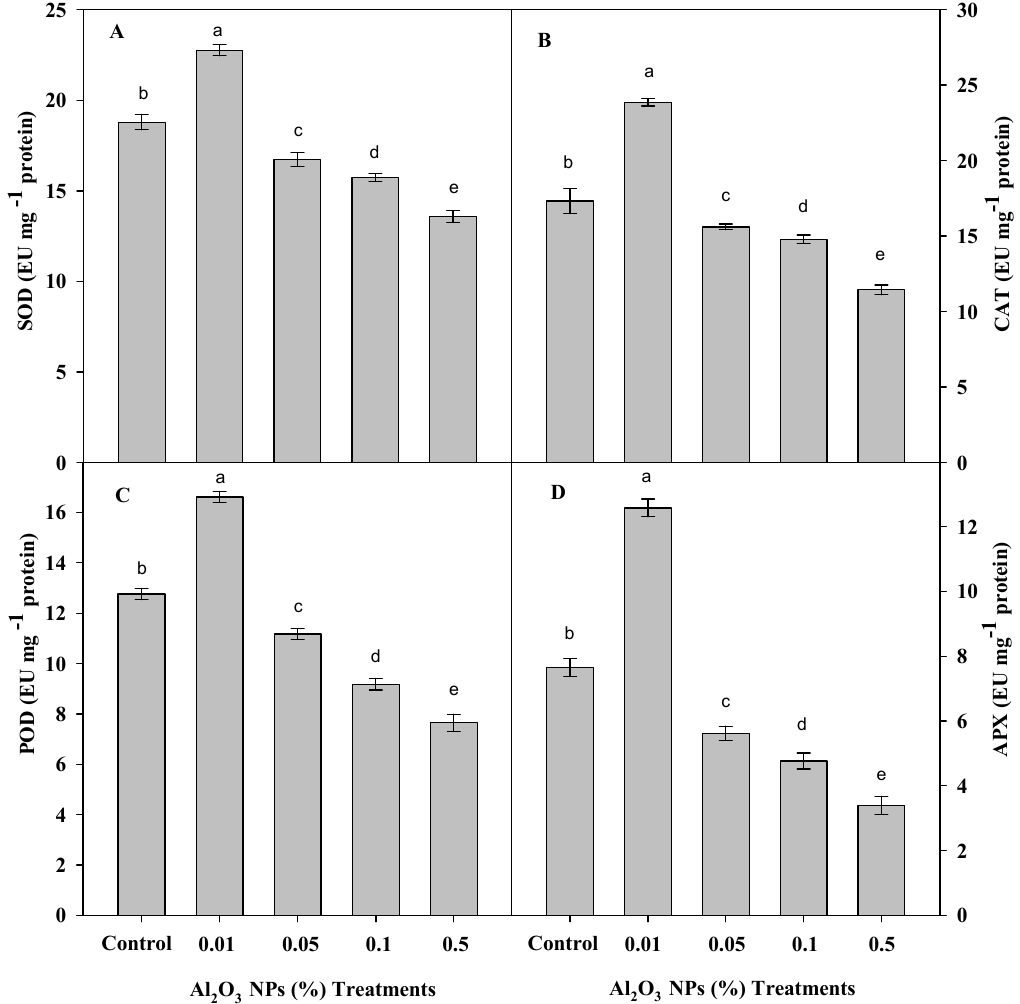
Figure 6. E ff ects of seed-priming with aluminum nanoparticles (Al 2 O 3 NPs) on the activities of ( A ) superoxide dismutase (SOD), ( B ) catalase (CAT), ( C ) peroxidase (POD), and ( D ) ascorbate peroxidase (APX) in leaves of roselle plants. Bars represent standard deviation ( ± SD) of the means ( n = 3). Di ff erent letters indicate significant di ff erences among the treatments at p < 0.05, according to Duncan’s multiple range test.